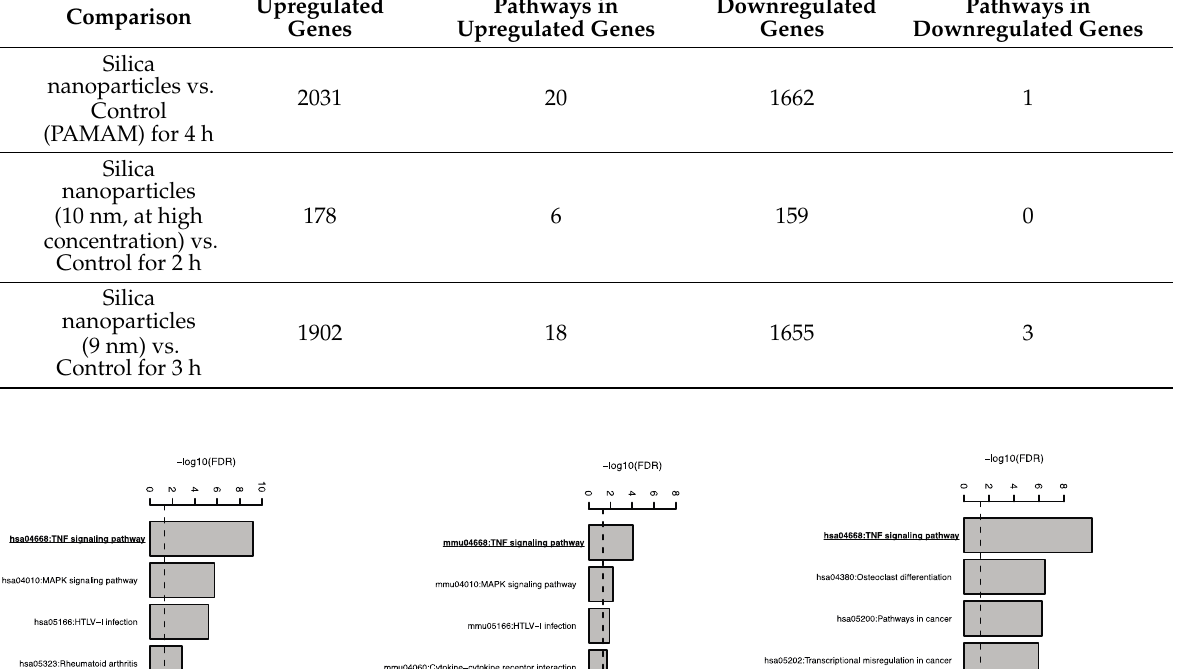
Table 1. Number of up-regulated/down-regulated genes and enriched pathways (FDR<0.05) identified from three micro- array data sets.